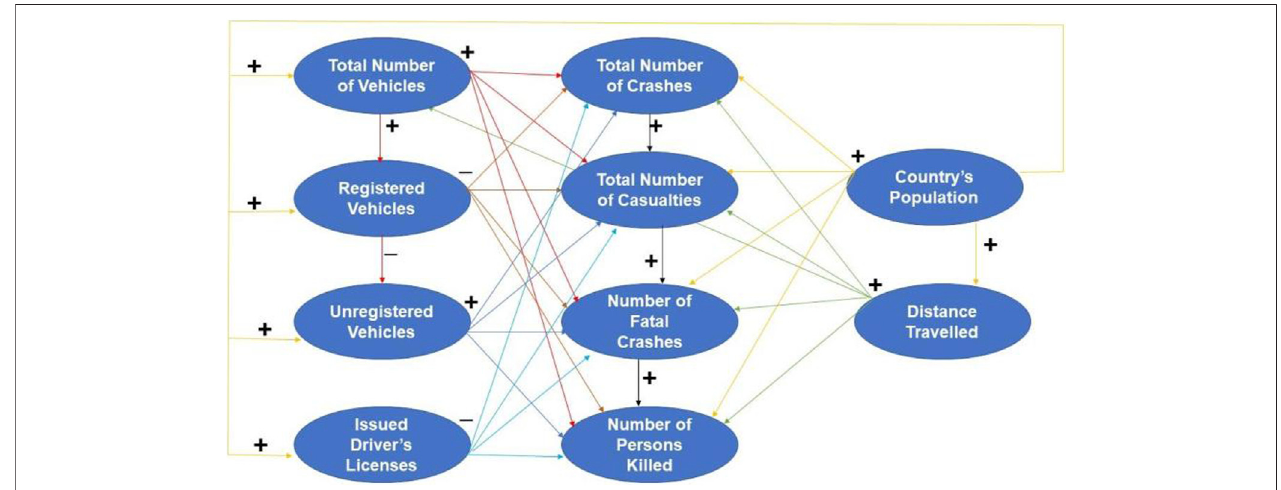
FIGURE 1 | Proposed theoretical metamodel to explain road accident events in South